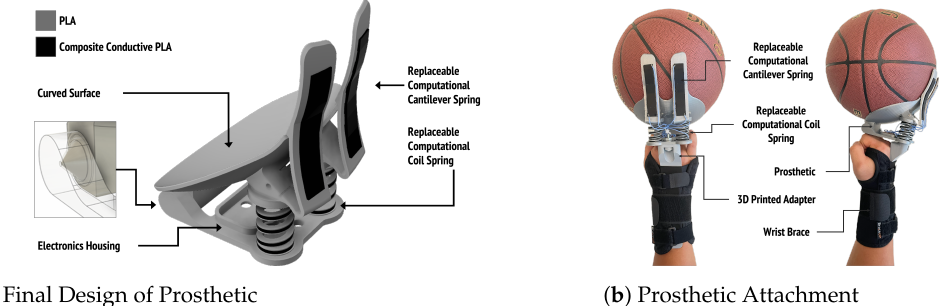
Figure 10. Individual components of the final prosthetic ( a ); the structure of our final design ( b ); final prosthetic attached to wrist brace via 3D printed